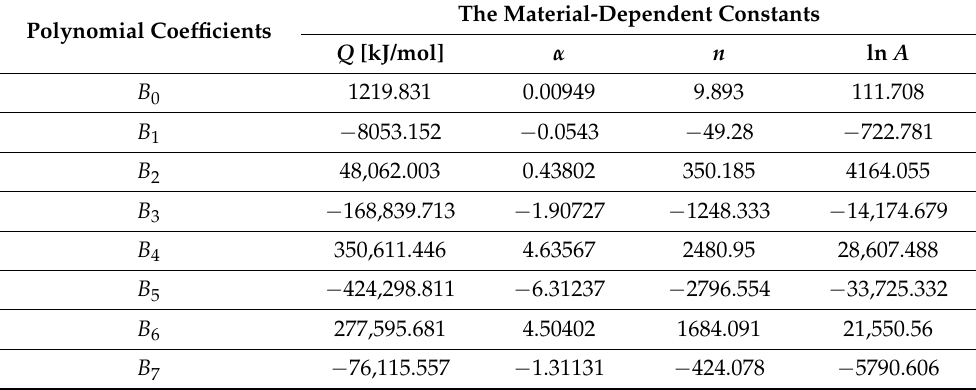
Figure 5. Seventh-order fitting curves of each of the material-dependent constants: ( a ) Q-ε ; ( b ) α-ε ; ( c ) n-ε ; ( d ) ln A-ε. Table 3. The coefficients of each polynomial